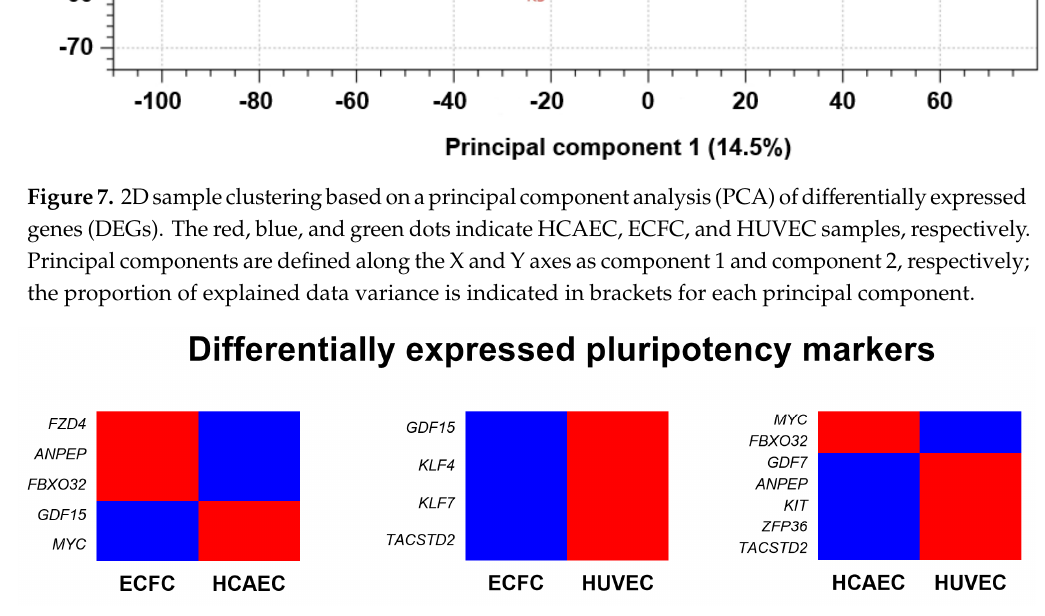
Figure 8. Heatmap showing the differential expression of pluripotency markers across ECFC, HCAEC, and HUVEC. Upregulated genes are colored red whereas downregulated genes are colored blue.